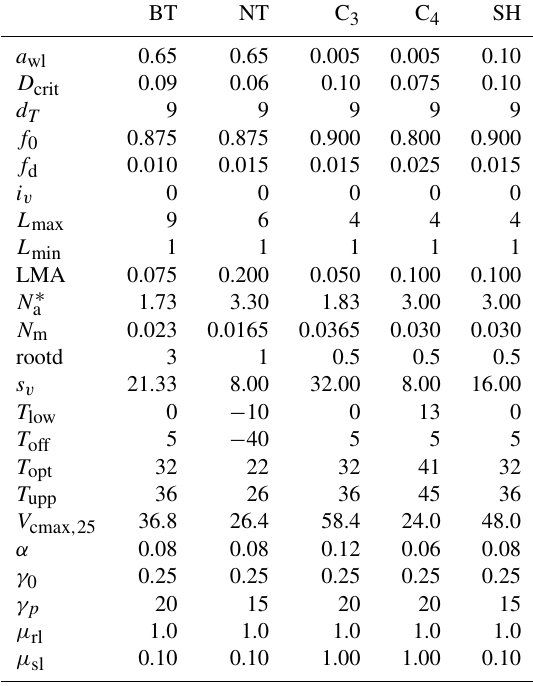
Table 1. Parameters used for the five PFT experiment (JULES5). The standard PFTs are broadleaf trees (BT), needle-leaf trees (NT), C 3 grass, C 4 grass, and shrubs (SH). N m was calculated by dividing the default N l0 by C mass (0.5 in this study), LMA was calculated as σ L × C mass , and s v was calculated to yield the same V cmax,25 as with the default five PFTs. All other parameters were taken from Clark et al. (2011). Parameters are defined in Table